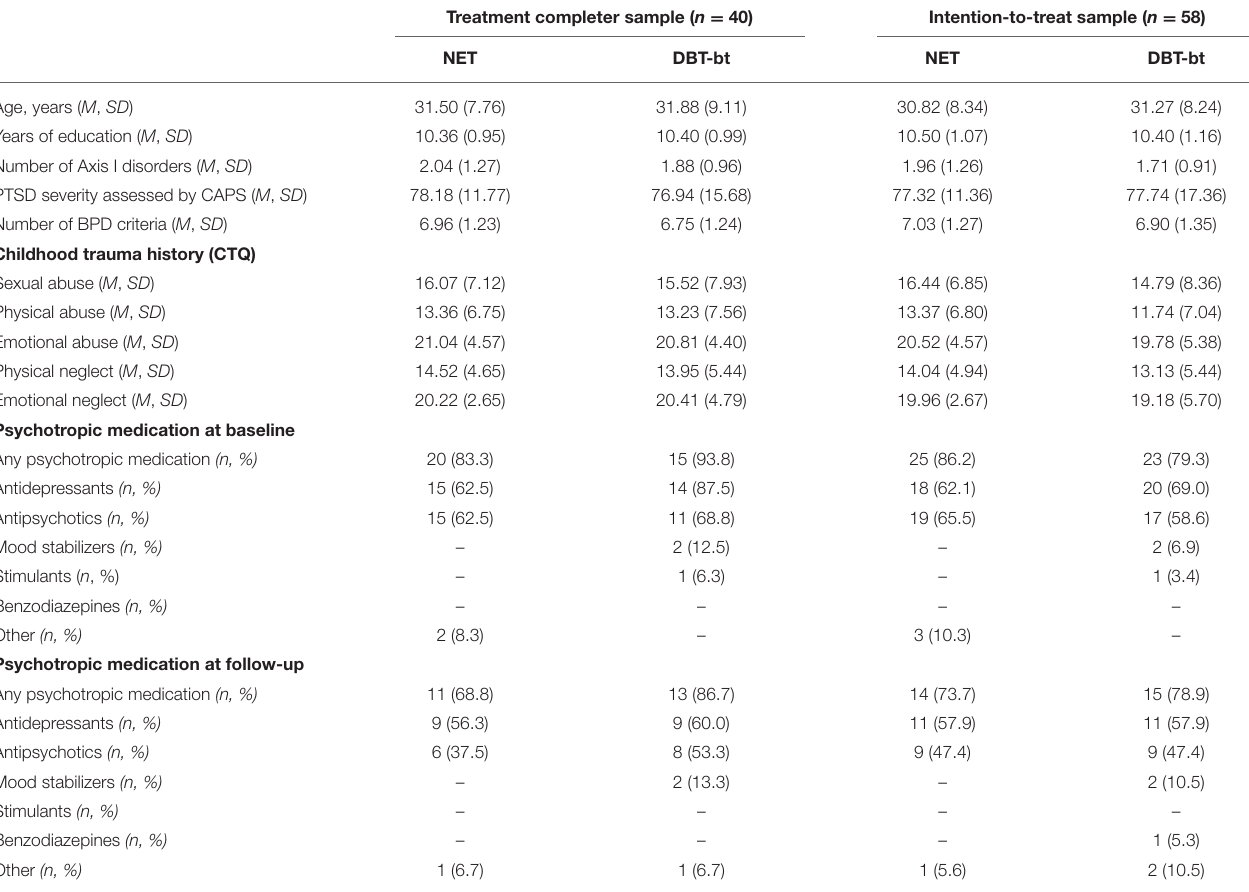
TABLE 1 | Patient characteristics and psychotropic medication.